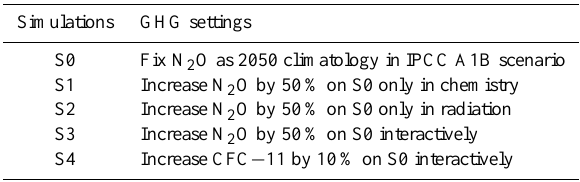
Table 2. The configurations of four CCM sensitivity